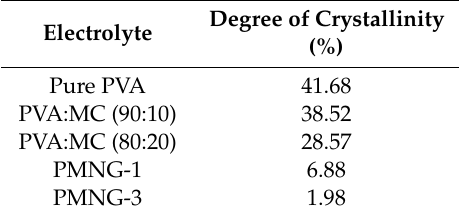
Table 1. The X c using deconvoluted XRD